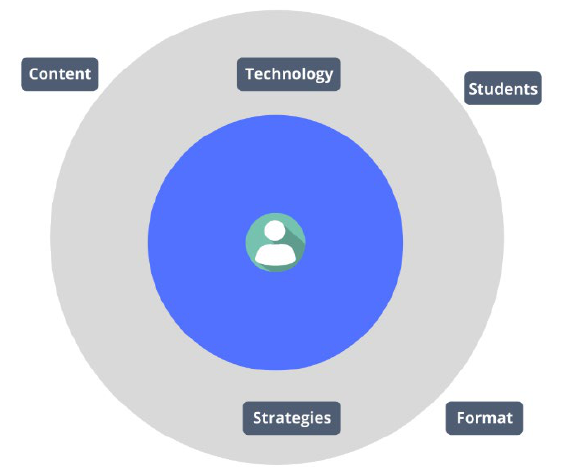
Figure 2. An adaptation of the Zones of Agency for Online Instructors model to depict a prescriptive course